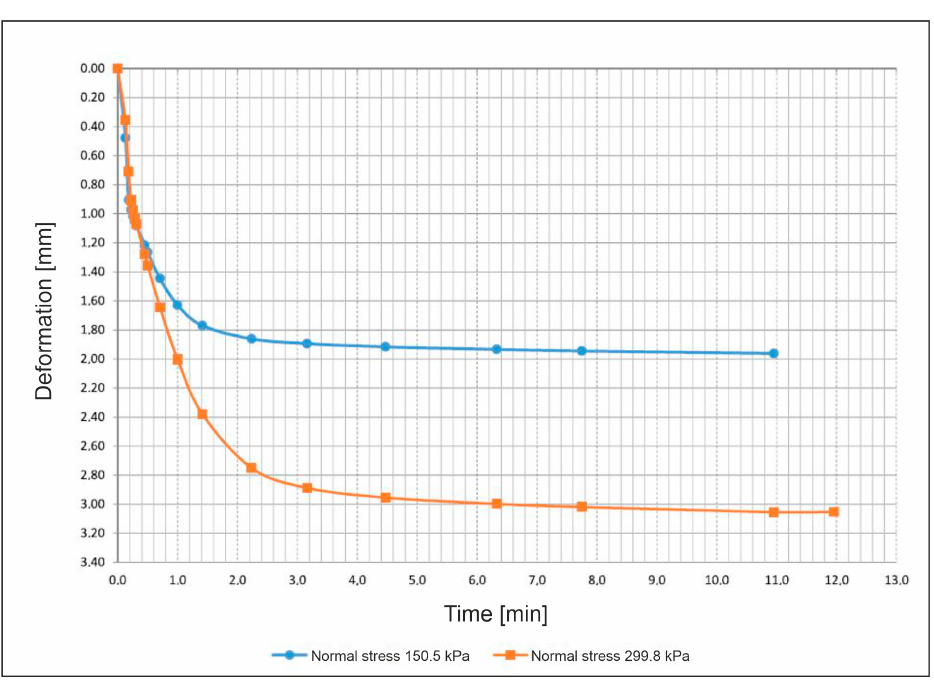
Figure 11. Shear-displacement curves.